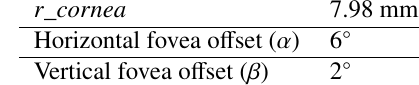
Default eye measures used in the simulation